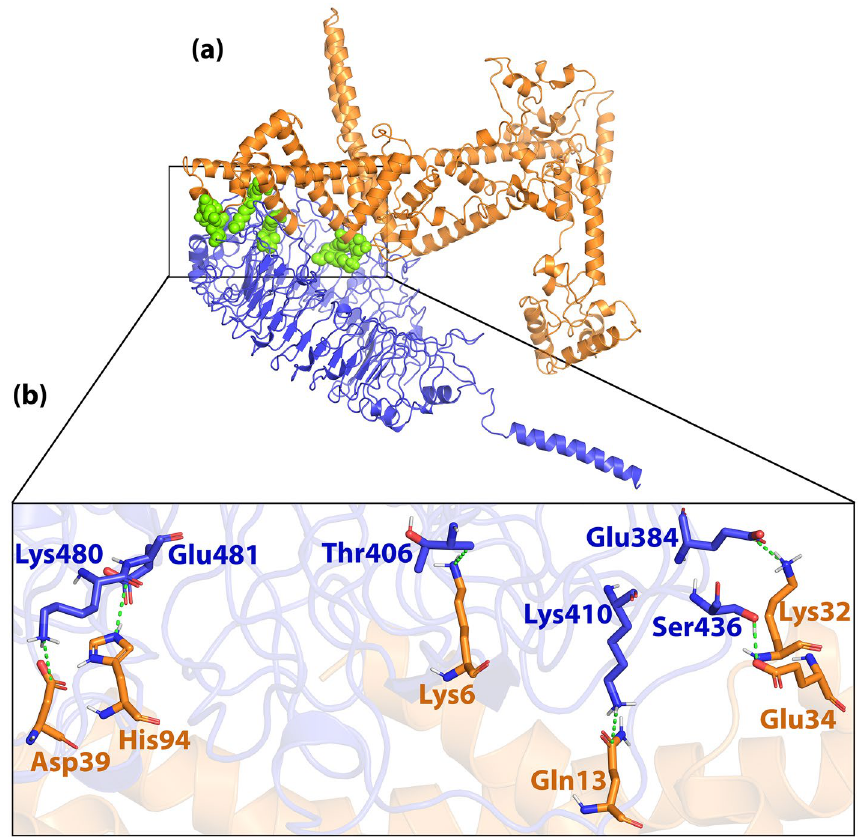
Figure 7. ( a ) Visualization of docking HADDOCK results for H7N9vac-TLR7 complex and ( b ) magnified residues interaction of H7N9vac-TLR7 complex. H7N9v structure is shown as the carton and sticks in copper color. TLR7 structure is shown as the carton and sticks in blue color. Hydrogen bonds are shown as the green dashed